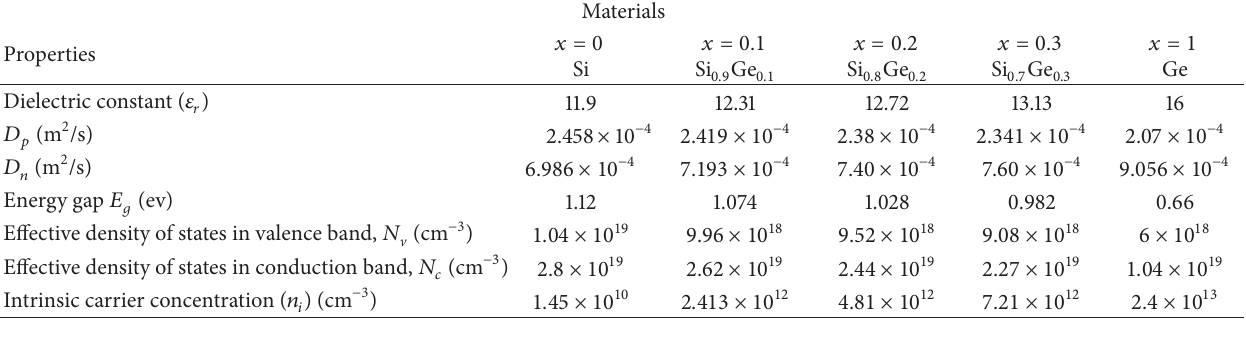
Table 1: SiGe parameters at different mole fraction.